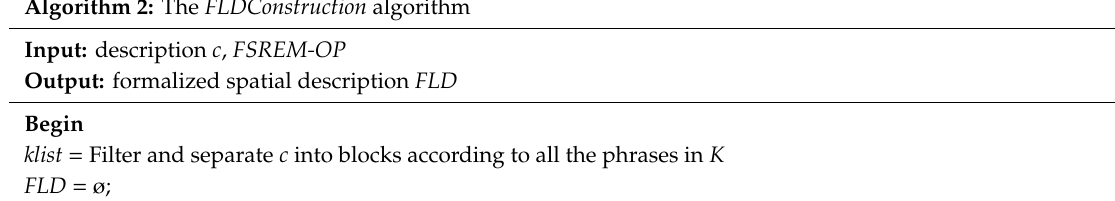
Algorithm 2: The FLDConstruction